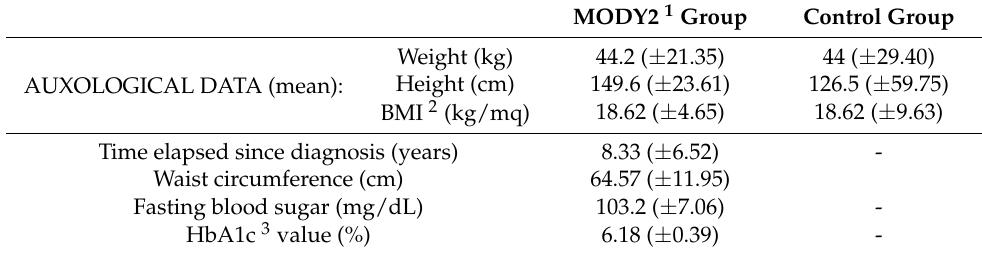
Table 2. Clinical characteristics of the overall study population.